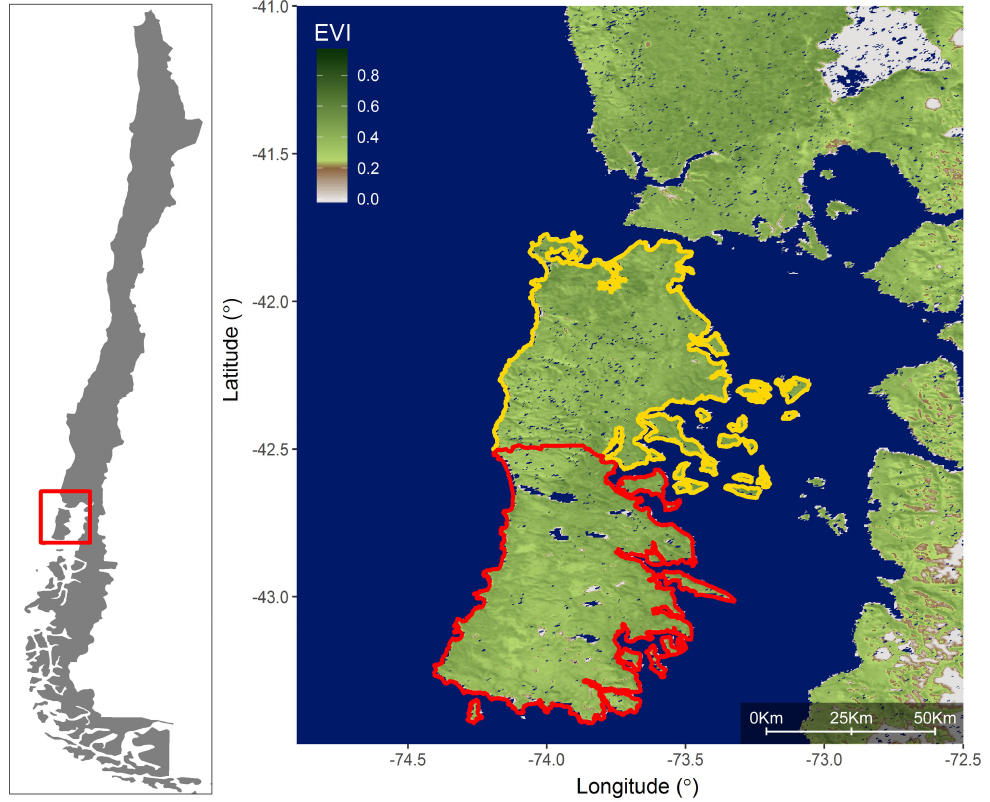
Figure 1. Study area: Chiloé Island System (CIS) coloured using the average EVI for all images over the 2001–2016 study period. Yellow and red polygons delimit the northern (yellow) and southern (red) regions described in our study. The color bar shows EVI